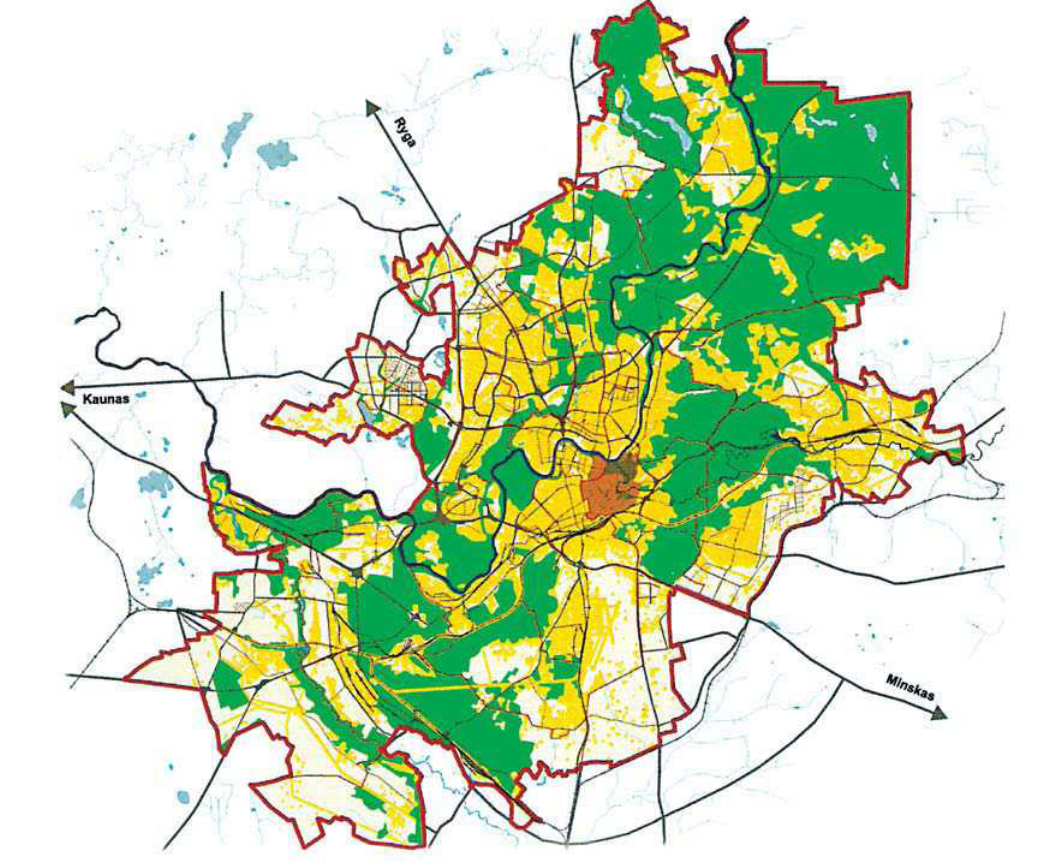
Fig 7. Current situation of natural subsystem in Vilnius,